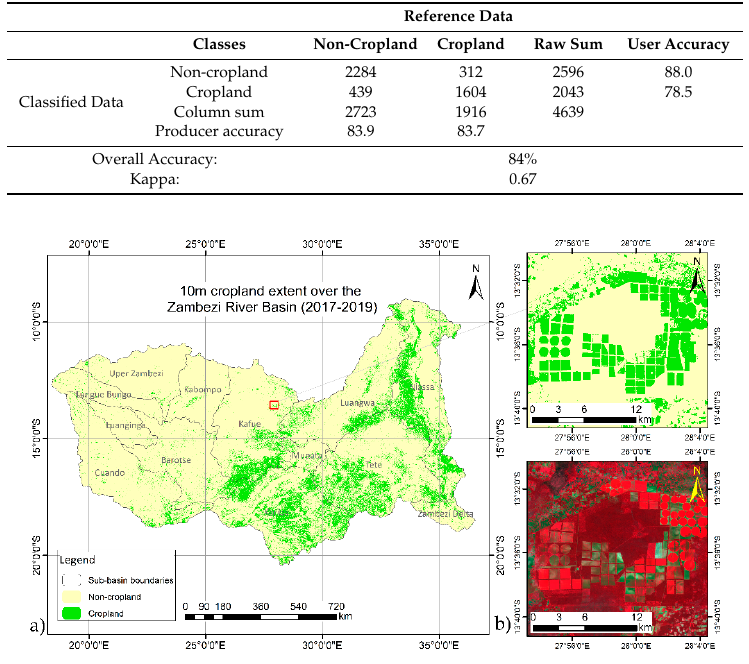
Table 8. Confusion matrix for the accuracy assessment of cropland maps in the ZRB.